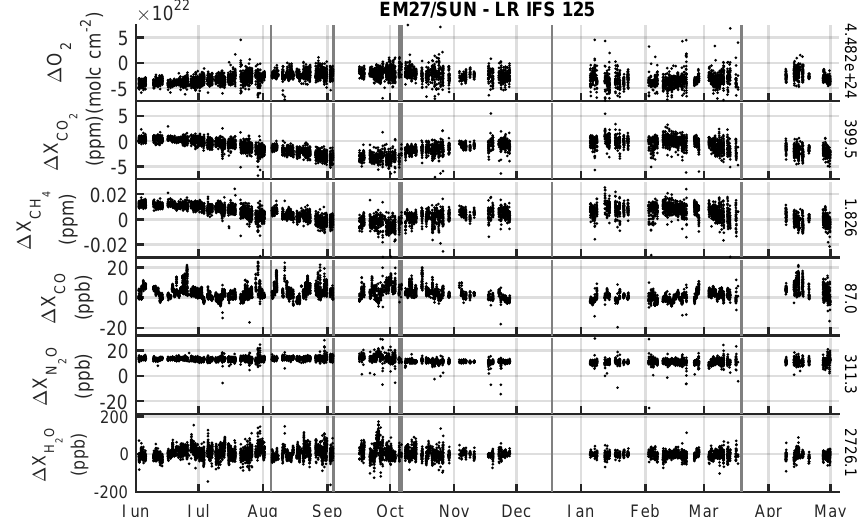
Figure 12. Time series comparison of EM27/SUN retrievals to retrievals from the 0.5cm − 1 resolution IFS 125HR